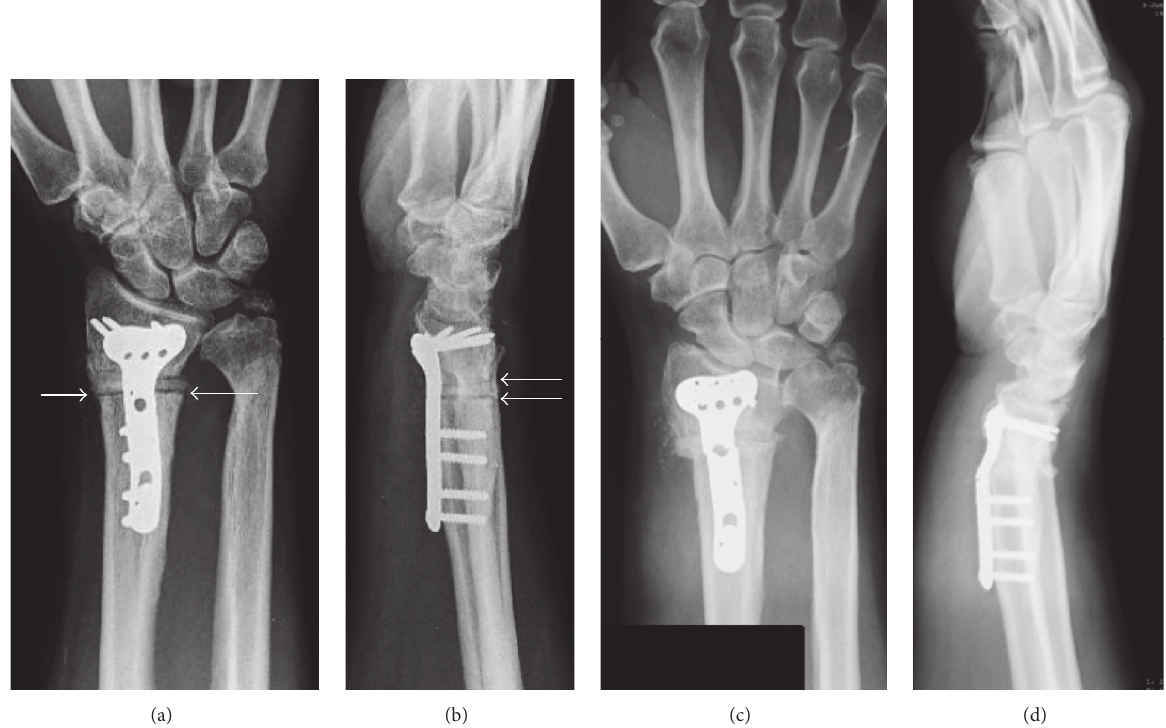
Figure 2: (a-b) Plain radiographs postoperative images at 3-month follow-up showed a development of radiolucent lines surrounding the graft at the osteotomy site (white arrows). (c-d) Plain radiographs postoperative images at 4-month follow-up showed plate breakage through the unfilled screw hole at the osteotomy site without plate bending or screw